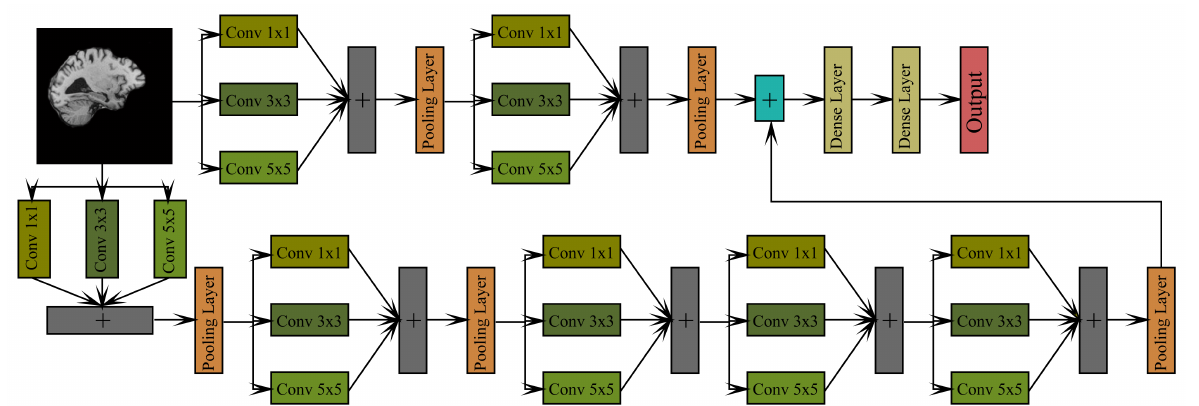
Figure 3. Block diagram of the proposed